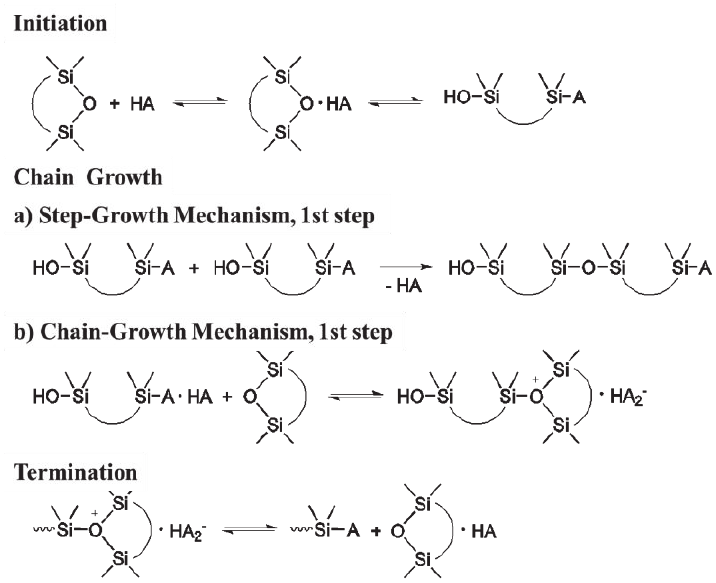
Figure 32. Two alternative propagation routes for the ROP of cyclic siloxanes: ( a ) Step-growth and ( b )